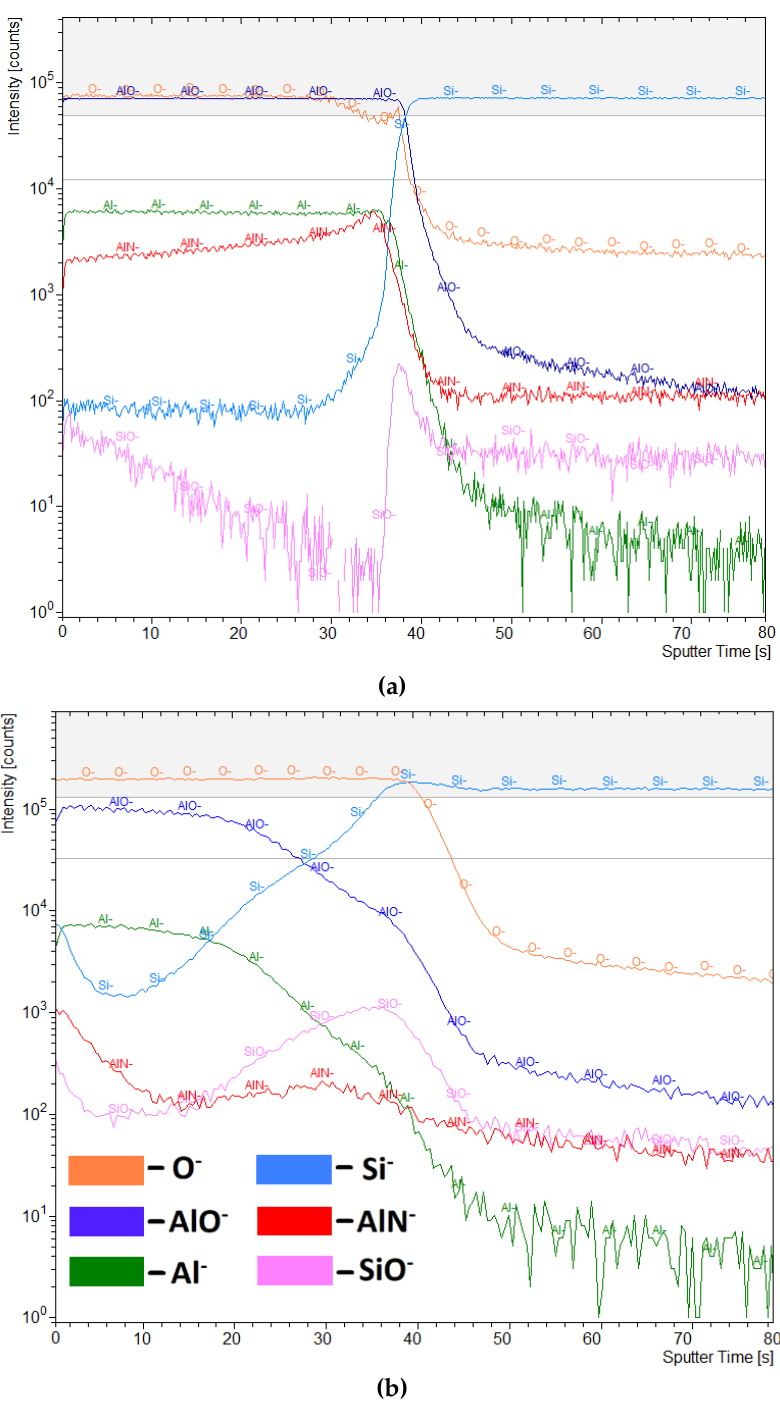
Figure 11. ( a ) Depth profile SIMS spectra for di ff erent ions for a sample without temperature treatment; ( b ) depth profile SIMS spectra for di ff erent ions for a sample with temperature treatment.